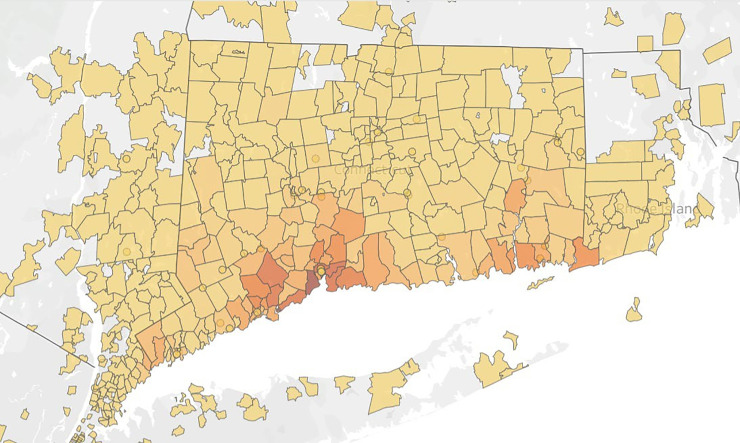
Population distribution of patients in the Yale Heart Failure Registry*.*Darker shading represents a greater density of patients in the registry from a zip code.